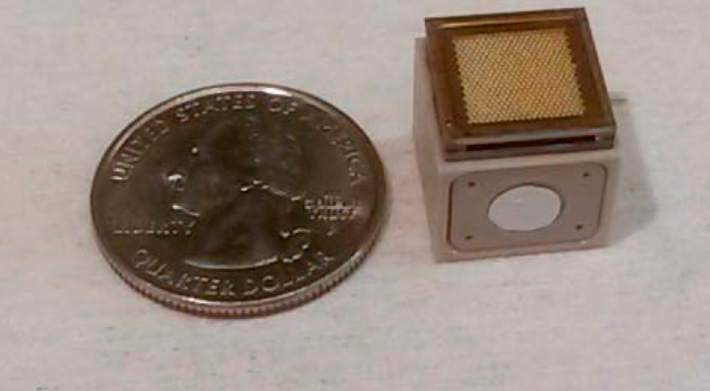
Figure 17. MIT Electrospray Thruster Compared to a U.S. Quarter Coin [37].